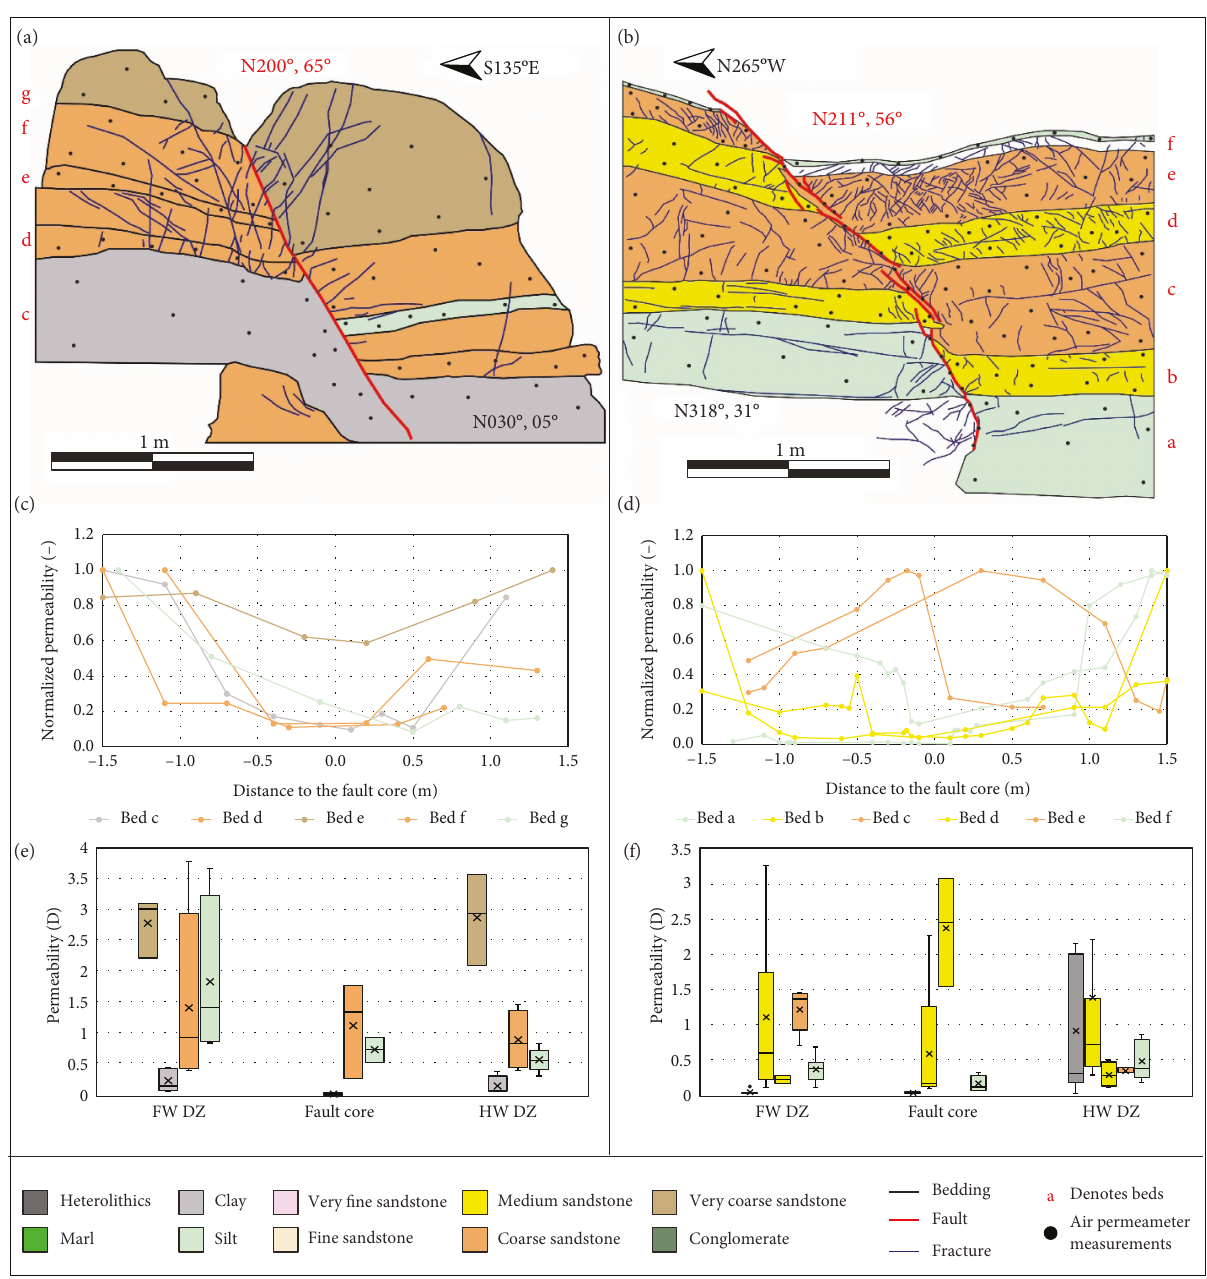
Figure 4: Permeability across incipient faults in di ff erent styles of multilayer package: line drawings (a) of the FIE fault, which cuts through packages of evenly distributed clay layers and (b) the FIU fault, which cuts through packages with unevenly distributed clay layers. Fault orientation is denoted in right hand rule with red text, whereas bed orientation is in black text; permeability normalized for bed thickness for the (c) FIE fault and (d) FIU fault; variation of permeability measurements shown in a box and whisker plot, in order to show the high variability across the damage zone in the hanging wall (HW DZ), the fault core, and the damage zone of the footwall (FW DZ) in (e) the FIE fault and (f) the FIU fault. Color meaning is denoted in the legend